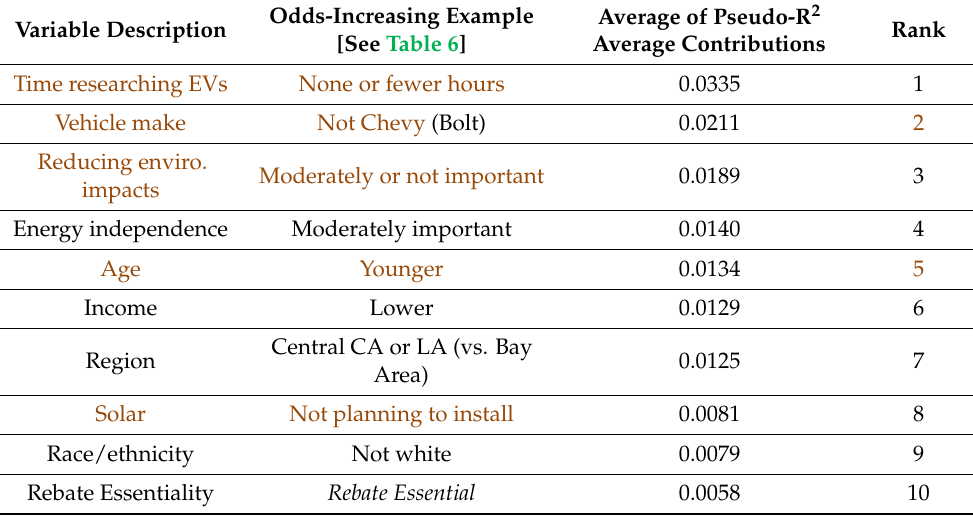
Table 8. Summary and Rank-Ordering of Key BEV Convert Predictors (Dominance